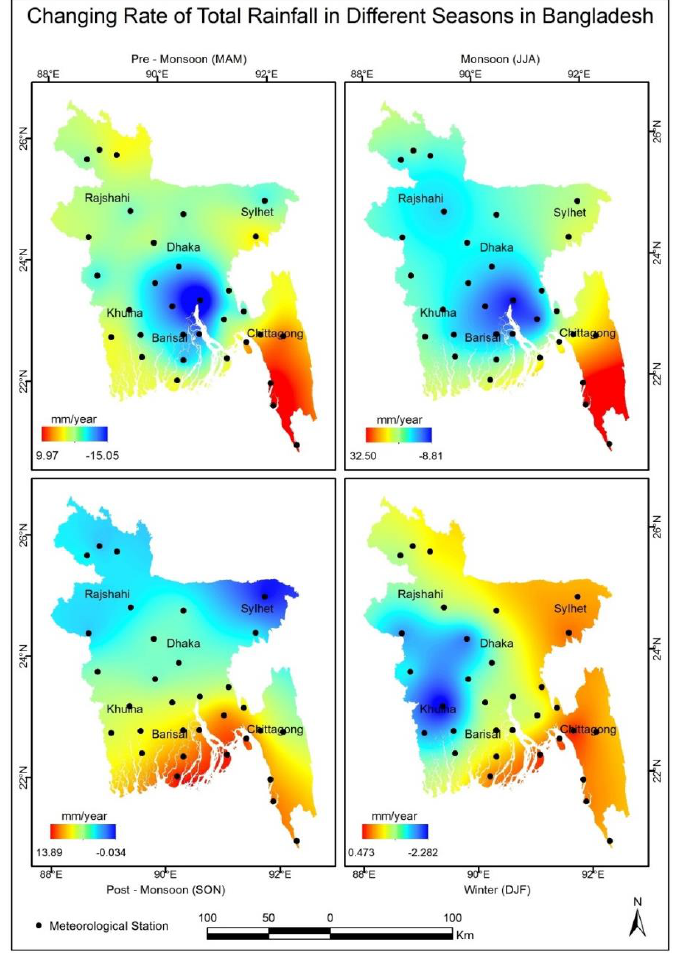
Figure 7. Geospatial distribution of changing trends in seasonal average rainfall.